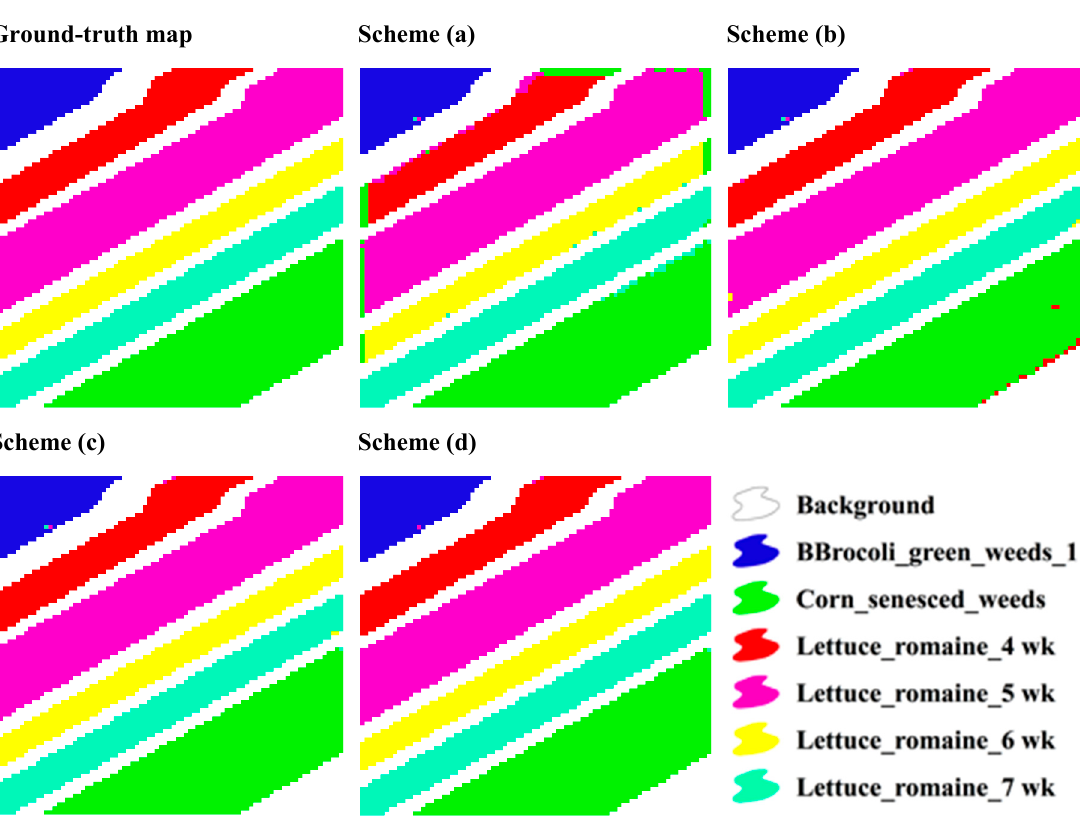
Table 7. User’s and Producer’s accuracy results (using 10% of the available training sample for the dataset), Overall accuracy and Cohen's Kappa of the HDCA with different schemes on the Salinas-A scene.